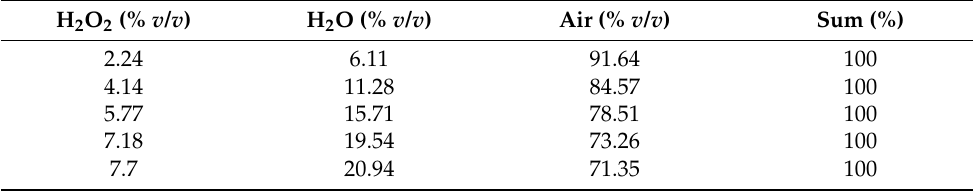
Table 2. An example of the relative water content in different gaseous H 2 O 2 concentrations.